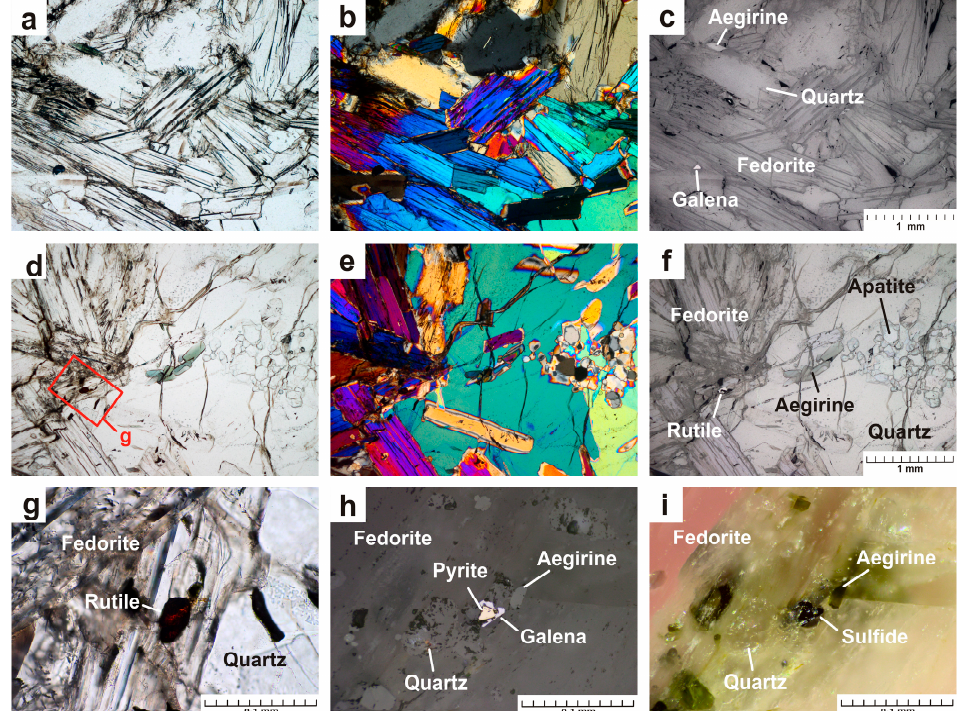
Figure 2. Polished thin section image of sample Gav-43 in transmitted ( a , b , d , e , g ) and reflected ( c , f ) light and polished sample Gav-43 in reflected light ( h ) and under side lighting ( i ); ( a , c , d , f , g , h , i )—polarizers are parallel, ( b , e )—polarizers are crossed. The interference color corresponds to a thickness of thin section (~40 μ m).